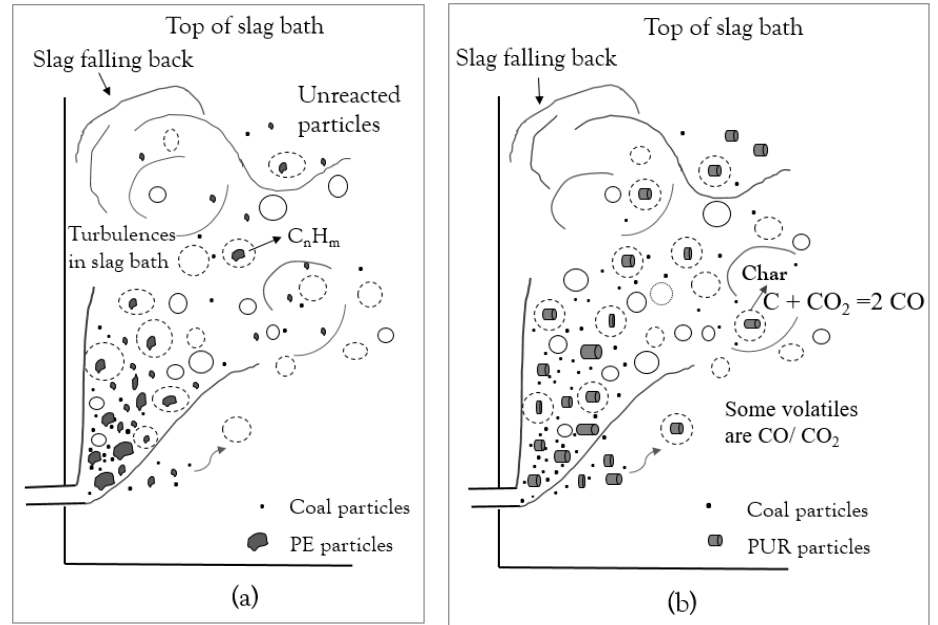
Figure 8. Schematic illustration of possible phenomena by plastic materials injection: with ( a ) PE and ( b ) PUR in the fuming furnace, unreacted particles will react at the top of the slag bath or in the combustion shaft and participate in steam generation; bubbles and particles recirculate by the motion of the